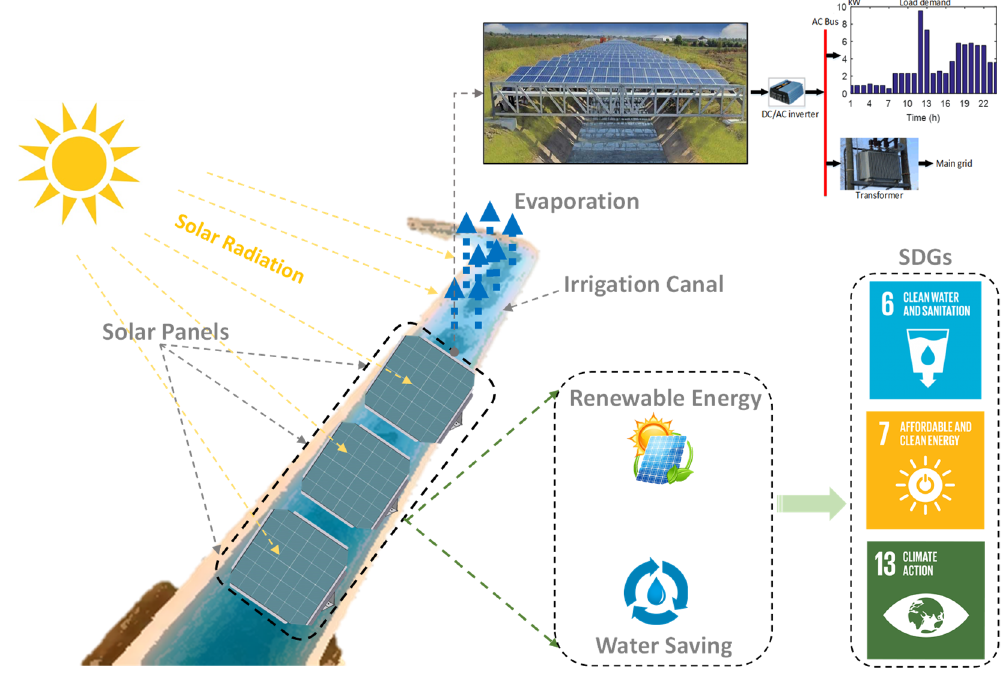
Figure 2. Structure of canal-top PV accommodation and its contribution to fulfilling SDGs..